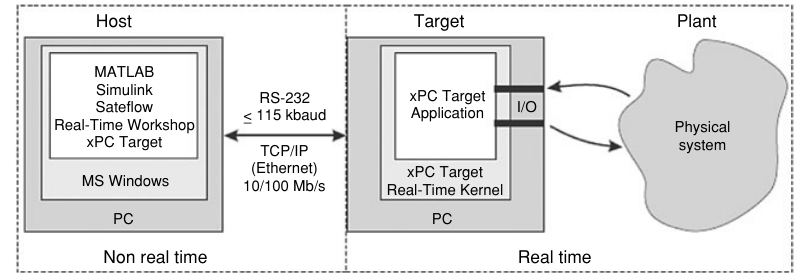
Figure 21 xPC Target system (Mosterman et al. 2005).